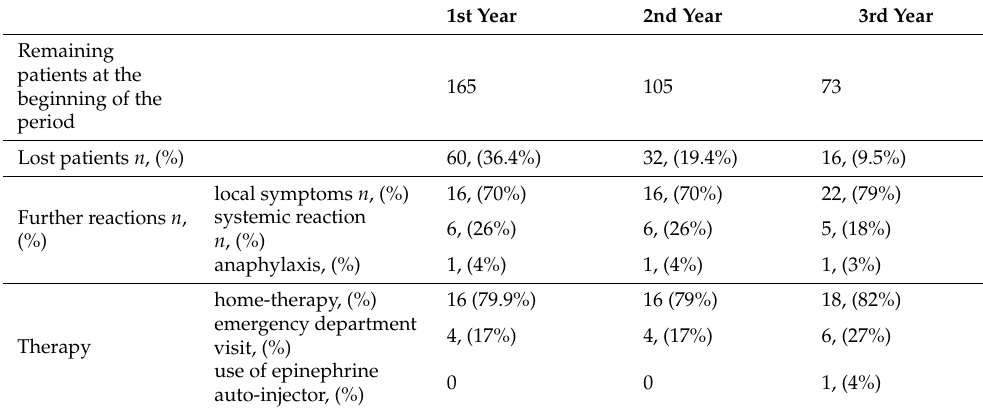
Table 2. Clinical severity and therapy of further reactions recorded during the follow-up.